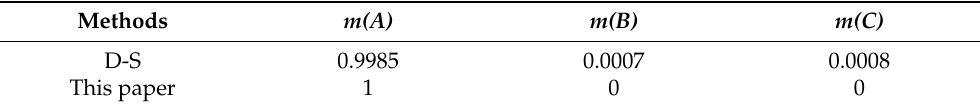
Table 10. Normal evidence fusion